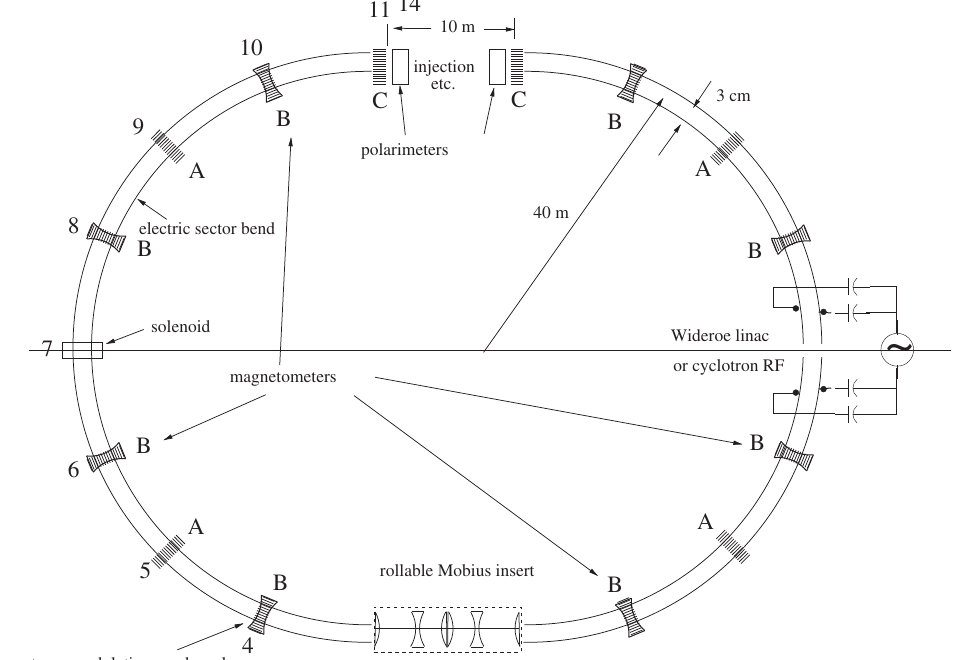
FIG. 6. Lattice for the long term tracking exhibited in Fig. 7. With the Möbius insert rolled by 45 degrees, horizontal and vertical betatron oscillations interchange every